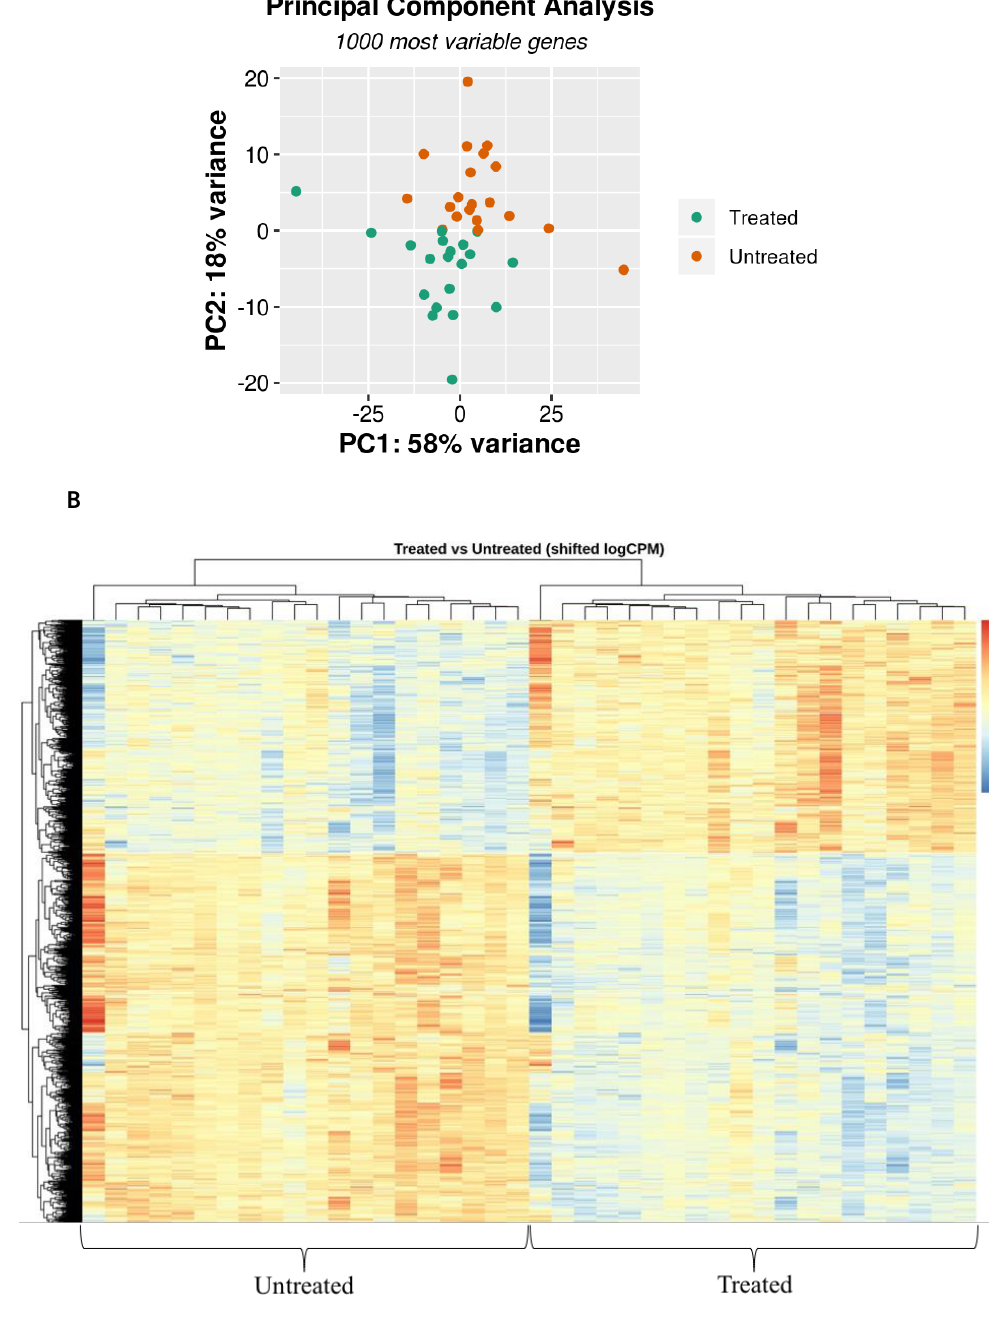
Figure 2. PCA and differential gene expression (DGE) induced by myriocin treatment in CF-patients- derived monocytes. ( A ) PCA was calculated considering the 1000 most variable genes across the dataset. Log-normalized counts were “shifted” for patient in order to take into account the experimental design adopted for DGE analysis. ( B ) Heatmap of DEGs with adjusted p -value < 0.05 resulted from the comparison between treated and untreated samples. The data used for creating this image were logCPM-corrected for patient batch and row-scaled (heatmap package).